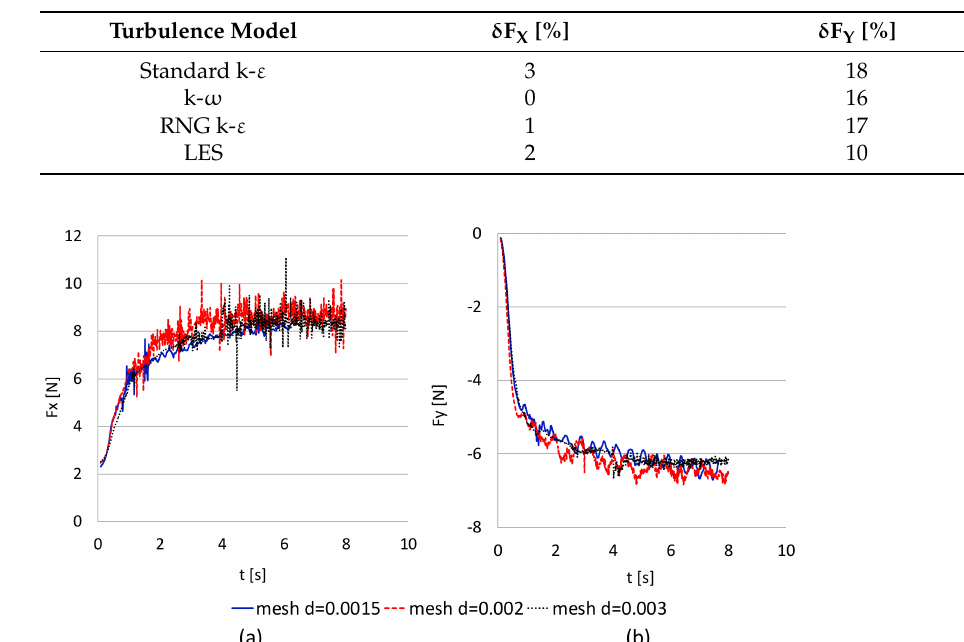
Table 6. Influence of turbulence model on the relative errors δ F X and δ F Y .